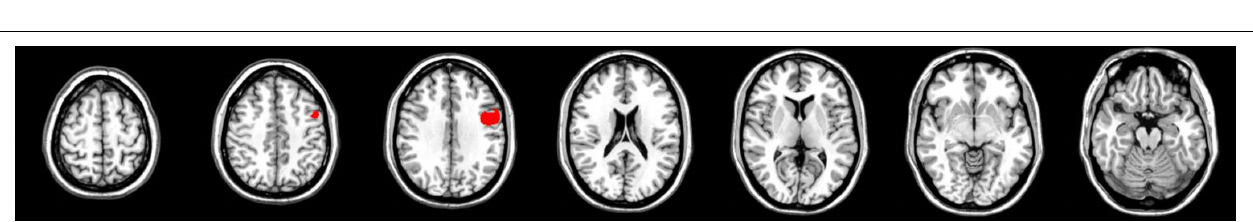
FIGURE 1 | Results for the CV measure, 600ms. Separate analyses were performed for left and right hemisphere-lesioned patients. All FDR cutoff values are q = 0.05. All images are in neurological convention.